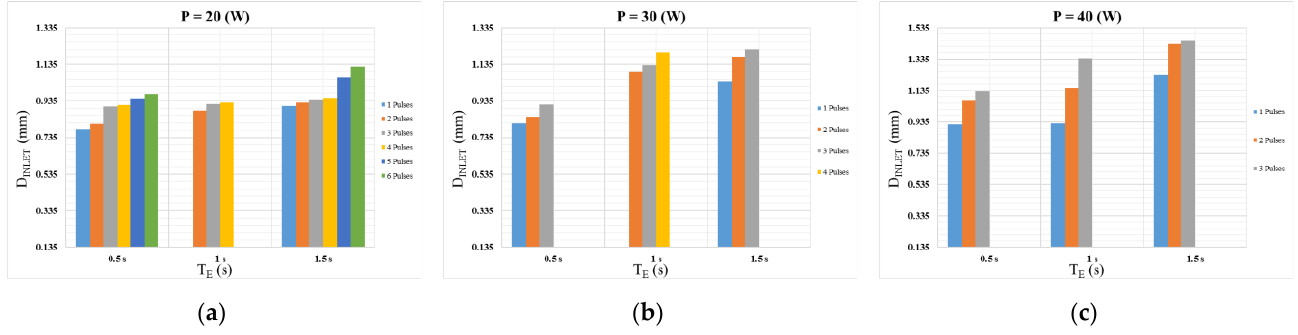
Figure 7. Influence of T E and N P on D INLET for 0.075 wt.% of CNPs and ( a ) P = 20 W, ( b ) P = 30 W and ( c ) P = 40 W.